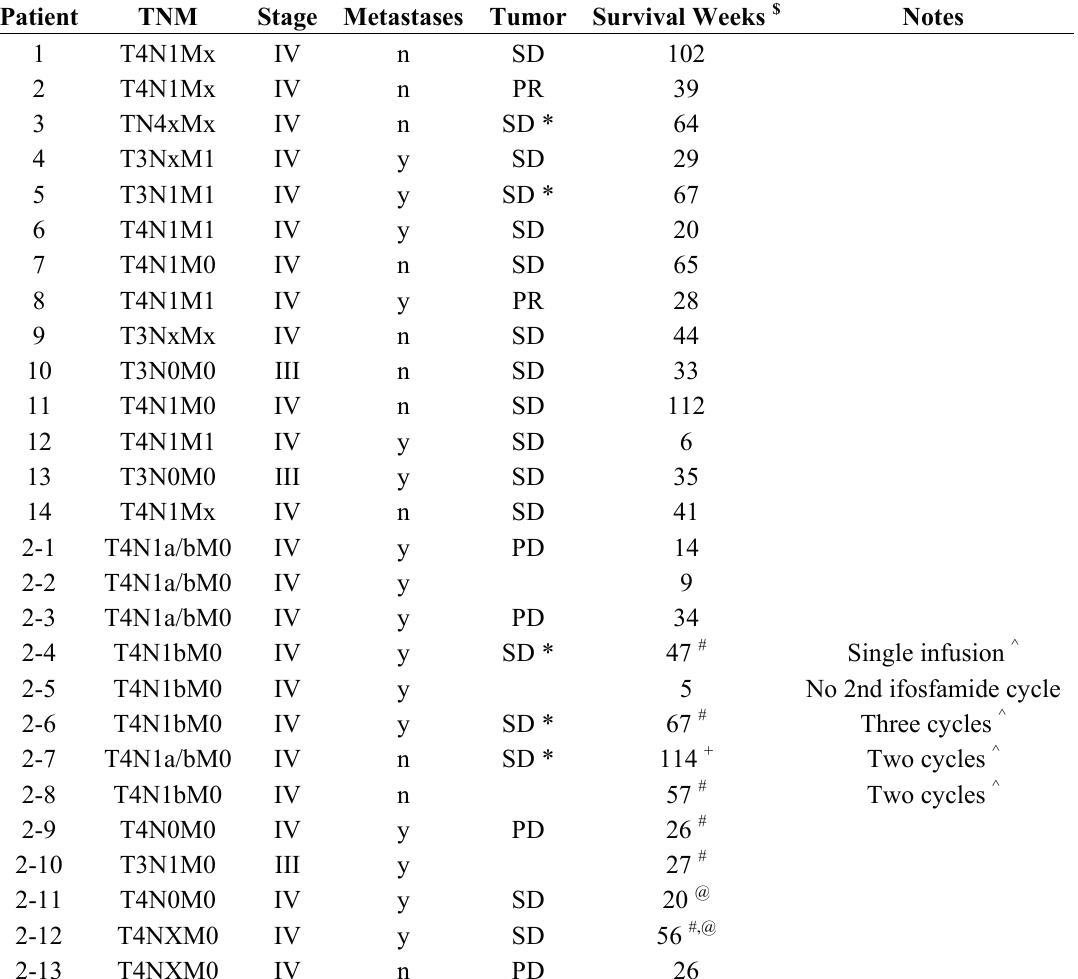
Table 4. Patient disease stage and response overview from both